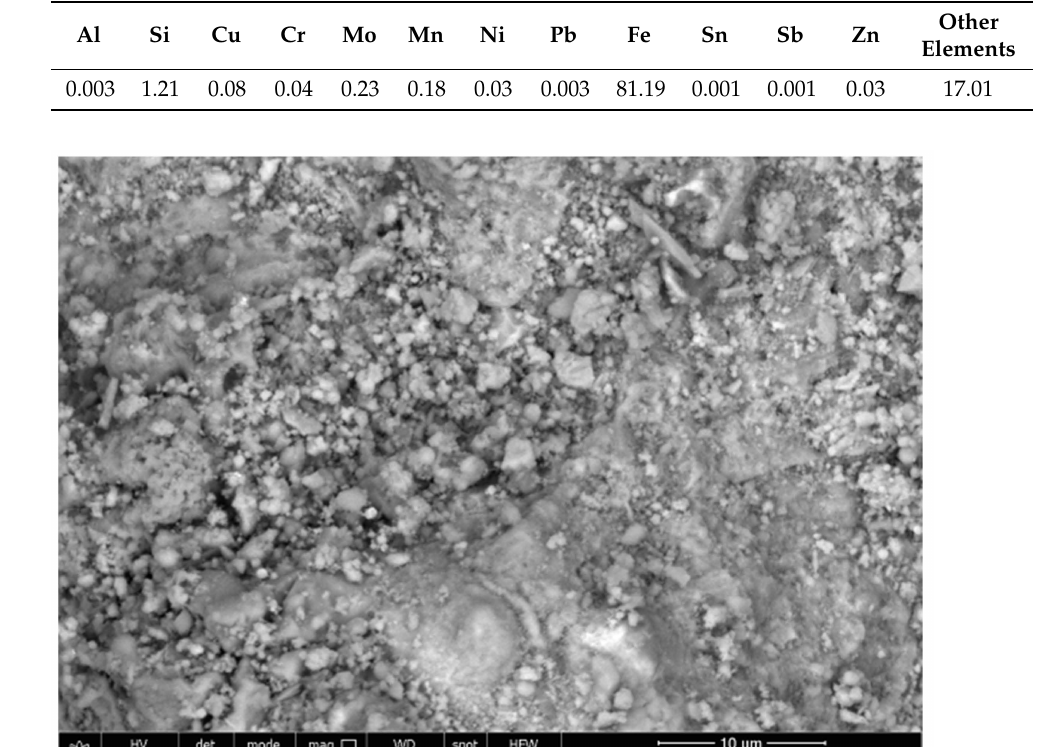
Table 3. Chemical composition of ferrous sludge, [%].